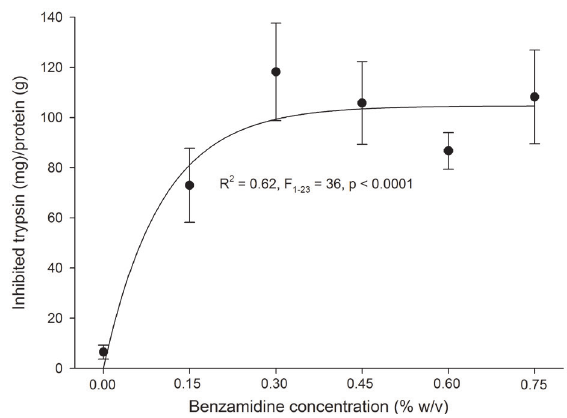
Figure 2 - Total proteolytic activity in the midgut extract from Anticarsia gemmatalis fed on soybean leaves sprayed with PI benzamidine at different concentrations. Point and line indicate mean ± SE of larvae in four